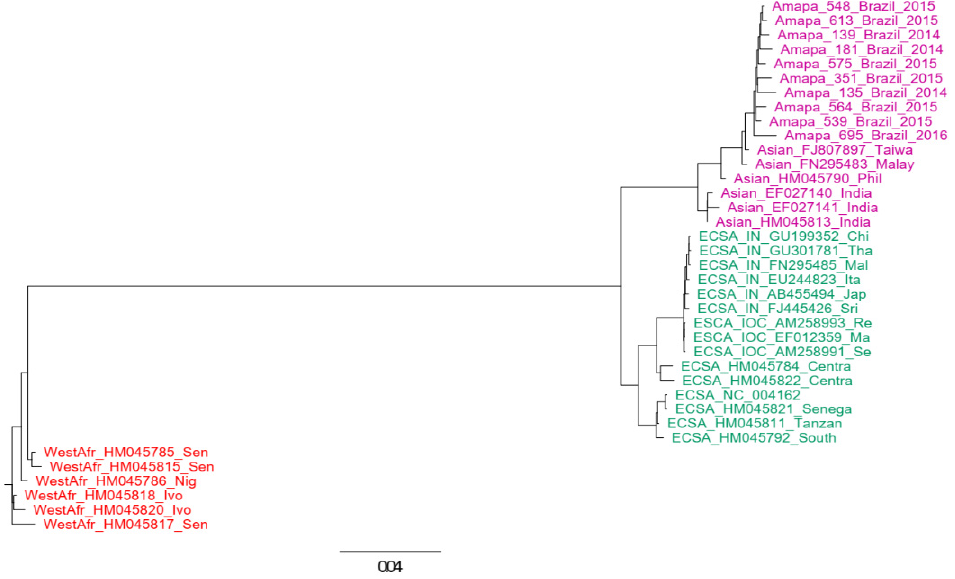
Figure 2. Genotyping tree of CHIKV. The tree was constructed using complete genomes of CHIKV. The maximum likelihood approach was used and the model GTR was assumed in this inference. Sequences of Asian lineage are indicated in magenta, those of West African lineage are in red, and those of ECSA are indicated in green. The horizontal bar indicates the nucleotide substitution per base.